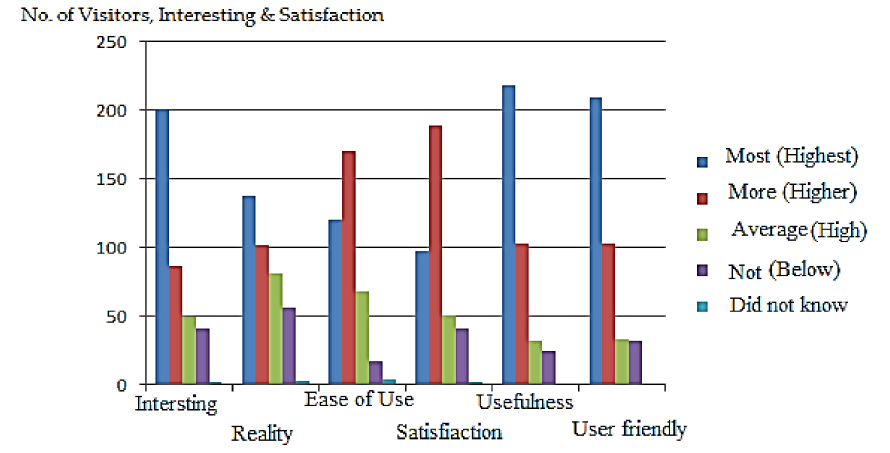
Figure 17. SNIS performance concerning six features and the number of